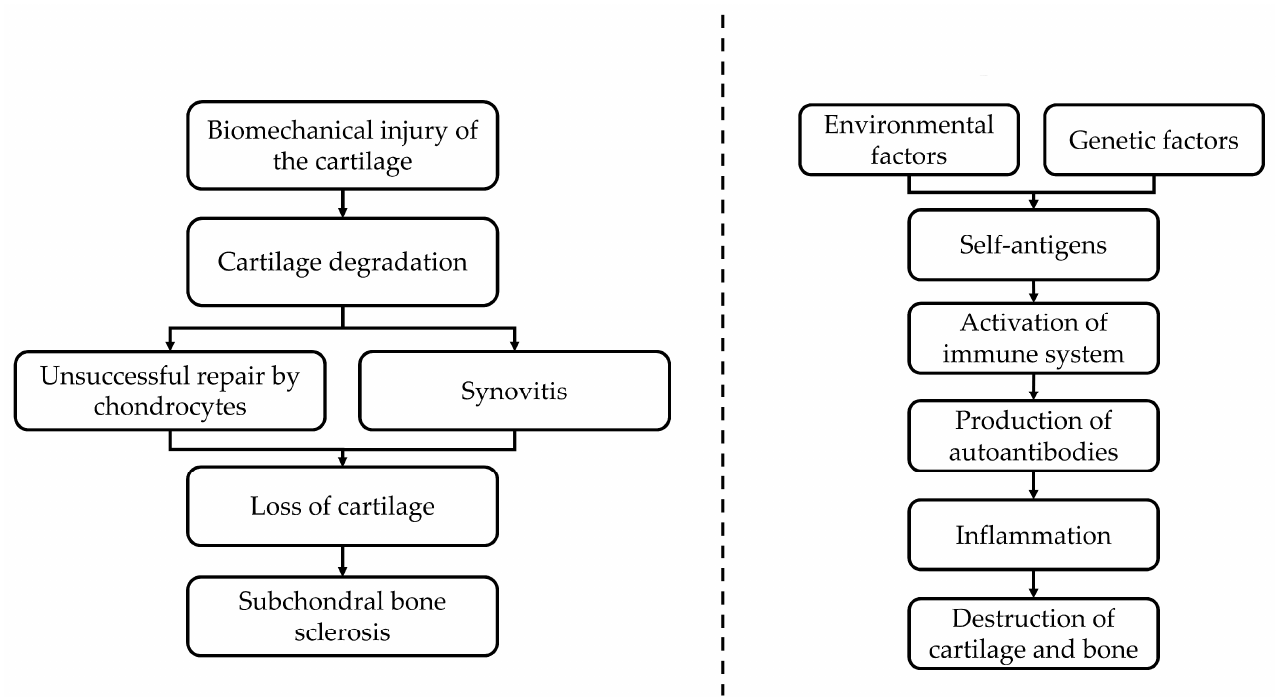
Figure 1. The pathogenesis of OA ( A ) and RA ( B ). OA is triggered by biomechanical injury and uncompensated healing of the cartilage layer, leading to local recurrent inflammation and the pro- gressive destruction of the cartilage, and subsequently, subchondral bone remodeling. Rheumatoid arthritis is caused by systemic inflammation triggered by the production of autoantibodies, leading to the destruction of cartilage and bone. ( A ) Pathogenesis of Osteoarthritis. ( B ) Pathogenesis of Rheumatoid arthritis.